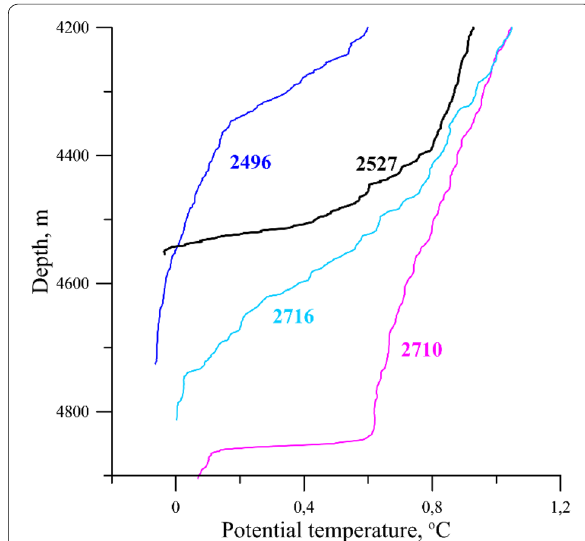
Fig. 5 Profiles of potential temperature below 4200 m at stations